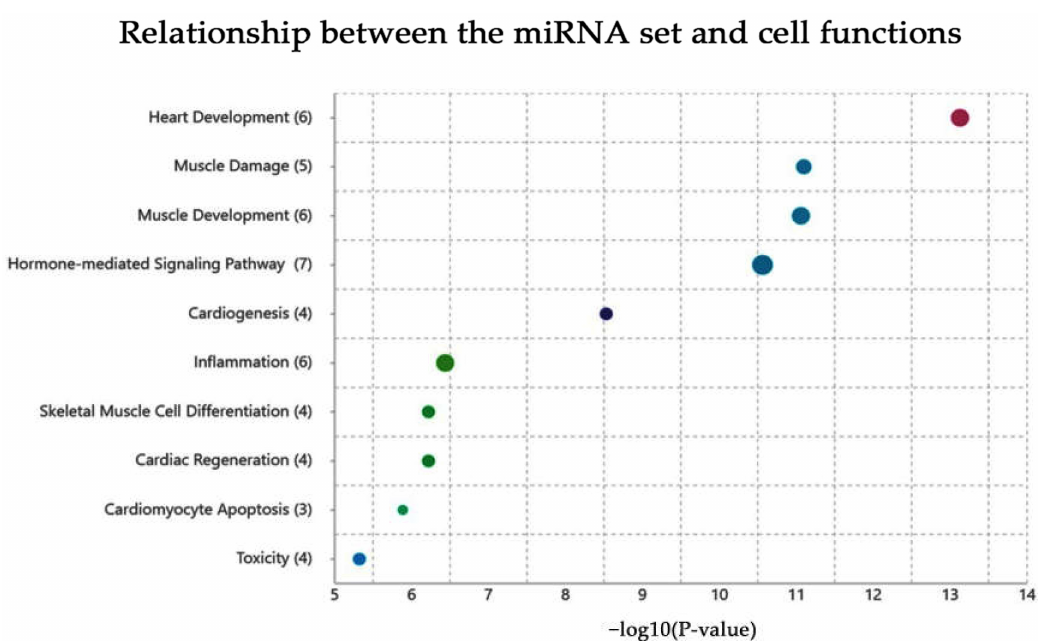
Figure 3. The relationship between the uploaded miRNA set and cell functions. As summarized in the graph, these miRNAs are involved in several essential functions, such as heart development, muscle damage, cardiogenesis, cardiac regeneration, and cardiomyocyte